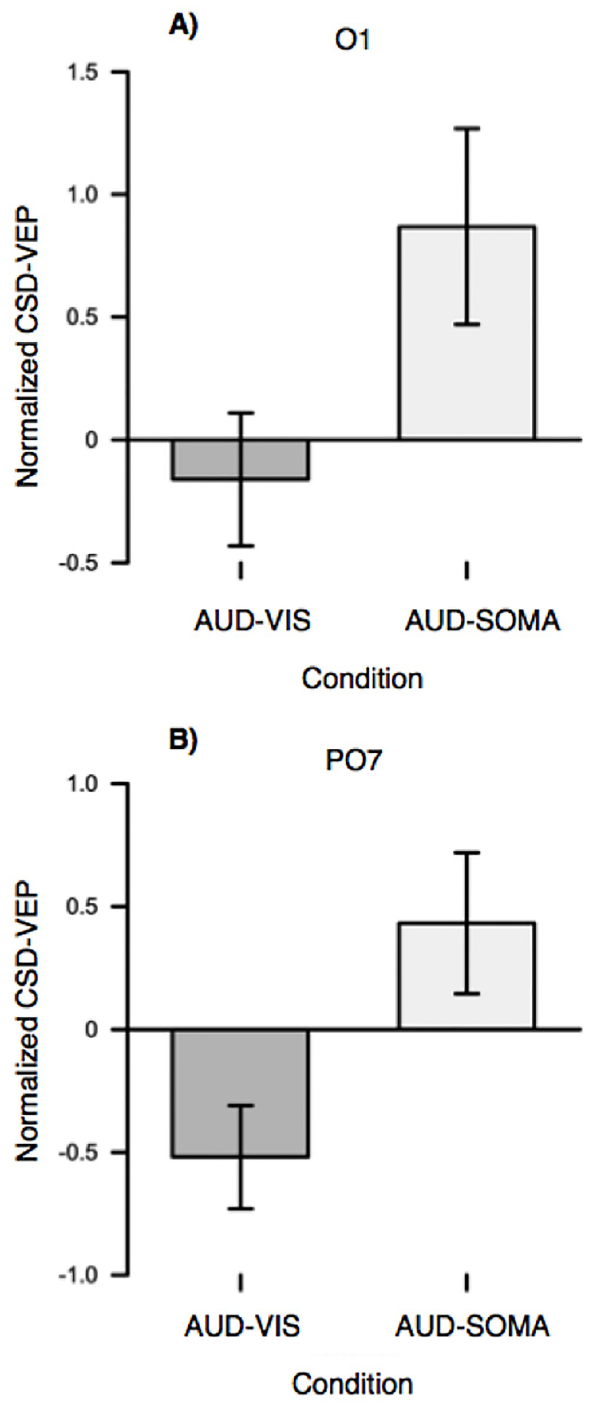
Fig 5. CSD normalized VEPs for the occipital (O1) and occipito-parietal (PO7) electrodes (error bars represent the standard error of the mean). For both electrodes, CSD- VEPs were significantly larger in the AUD-SOMA compared to the AUD-VIS